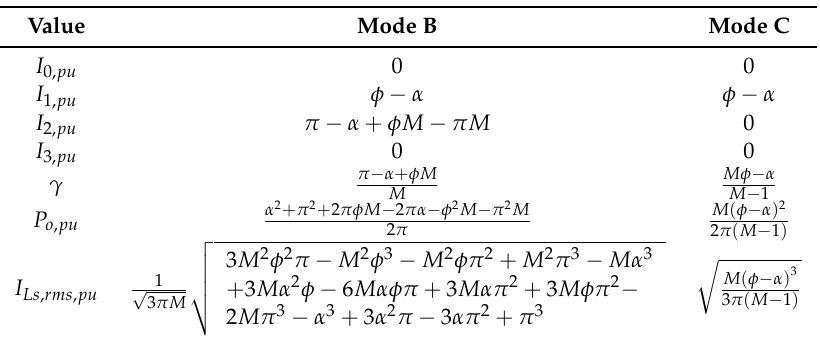
Table 2. Theoretical values of inductor current and output power in